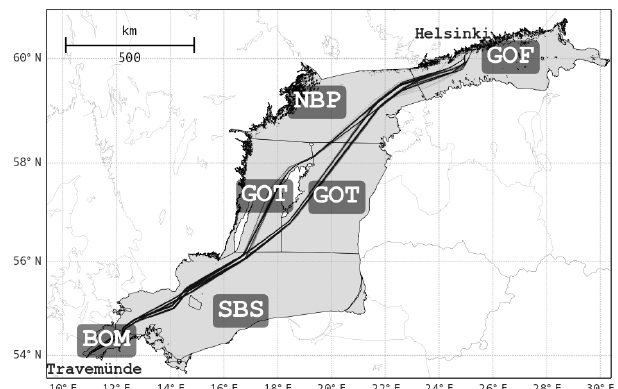
Figure 1. Illustration of threshold-based bloom metric behaviour when applied to a data set with a negative peak concentration trend.